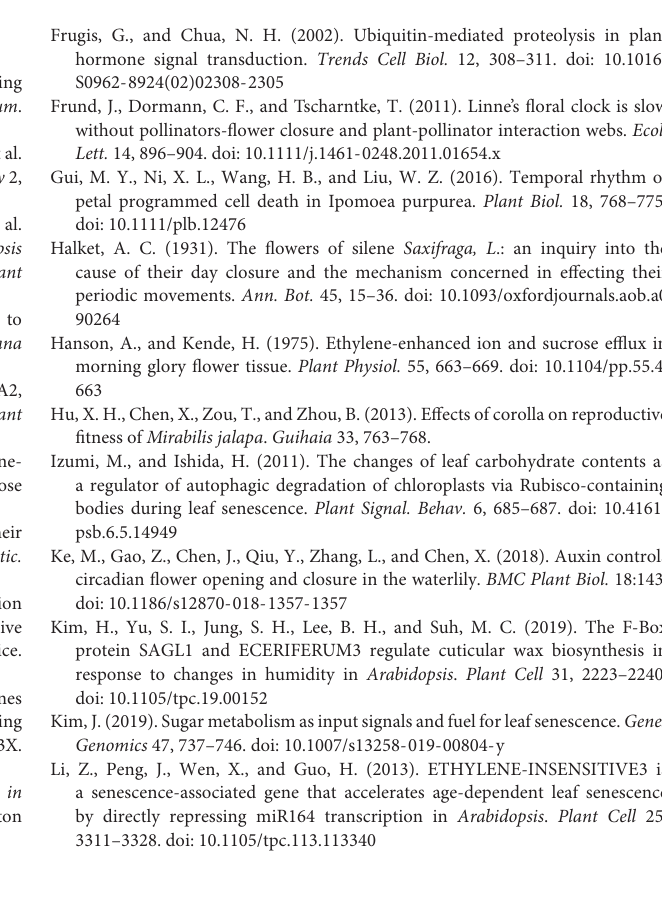
Supplementary Figure 1 | The corolla determines flower closure movements. (A) Closure of a corolla without stamens or a pistil. (B–D) Photographs of corolla closure in flowers lacking 1/3, 2/3, or all of the colorful corolla. Scale bar = 2 mm. Supplementary Figure 2 | Transverse sections from different parts of a corolla generated by freehand dissection. (A) Corolla limb, (B) intermediate, and (C) Corolla tube parts of corolla. Scale bars = 40 µ m. Supplementary Figure 3 | Annotation and principal component analysis (PCA) of transcriptomic changes in different stages of corolla closure. (A) Pie chart showing the species distribution. (B) PCA of transcriptomes at stages S0 to S3. The circles around the points represent different stages. Supplementary Figure 4 | Significantly enriched KEGG pathways in each cluster. Circle size represents the enrichment score and colors (from green to red) represent the significance of enrichment (from low to high) calculated by hypergeometric test. (A) cluster 1; (B) cluster 2; (C) cluster 3; (D) cluster 4; (E) cluster 5; (F) cluster 6. Supplementary Table 1 | List of unigenes quality indices of the 12 samples. Supplementary Table 2 | List of differentially expressed genes during corolla closure. Supplementary Table 3 | List abbreviation of DEGs in each heat map. Supplementary Table 4 | List of primers used for qRT-PCR